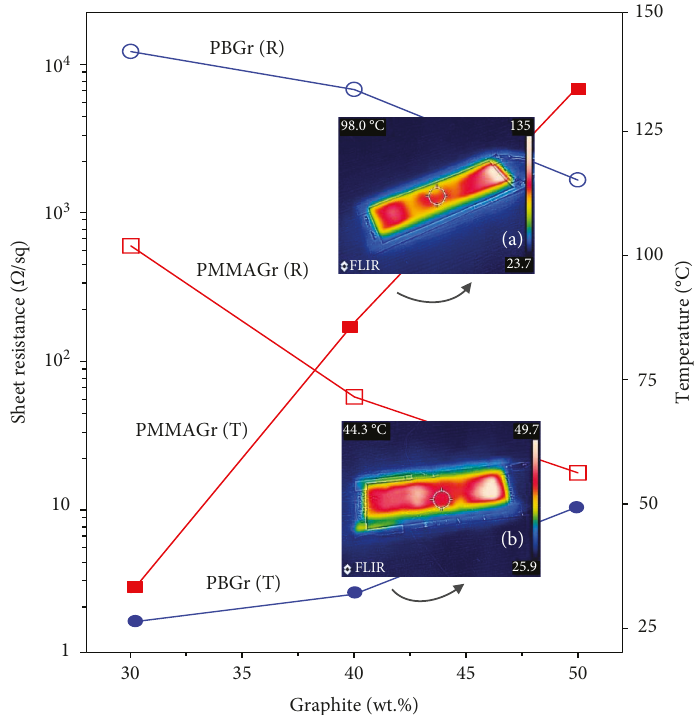
Figure 5: Sheet resistance and heating temperature as a function of the amount of graphite added to the heating fi lm. Open symbols ( ○ and □ ) and fi lled symbols ( ● and ■ ) represent the sheet resistance and the temperature measured in the fi lm, respectively. The abbreviations in the fi gure represent as follows: PBGr: polybutadiene/graphite composite fi lm; PMMAGr: poly(methyl methacrylate)/graphite composite fi lm. ( R ) and ( T ) after the abbreviations mean the sheet resistance and the temperature, respectively. Infrared thermal images were taken from the heating fi lms while applying DC power of 24 V; (a) PMMAGr and (b) PBGr fi lms including 50wt.% of graphite. Thickness of both fi lms was about 100 μ